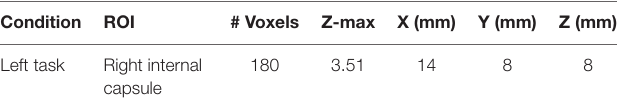
TABLE 2 | Voxels displaying positive parameter estimates for the timepoint 1 > timepoint 3 contrast of the dispersion derivative ( z > 2.5, P < 0.05, FWE corrected).